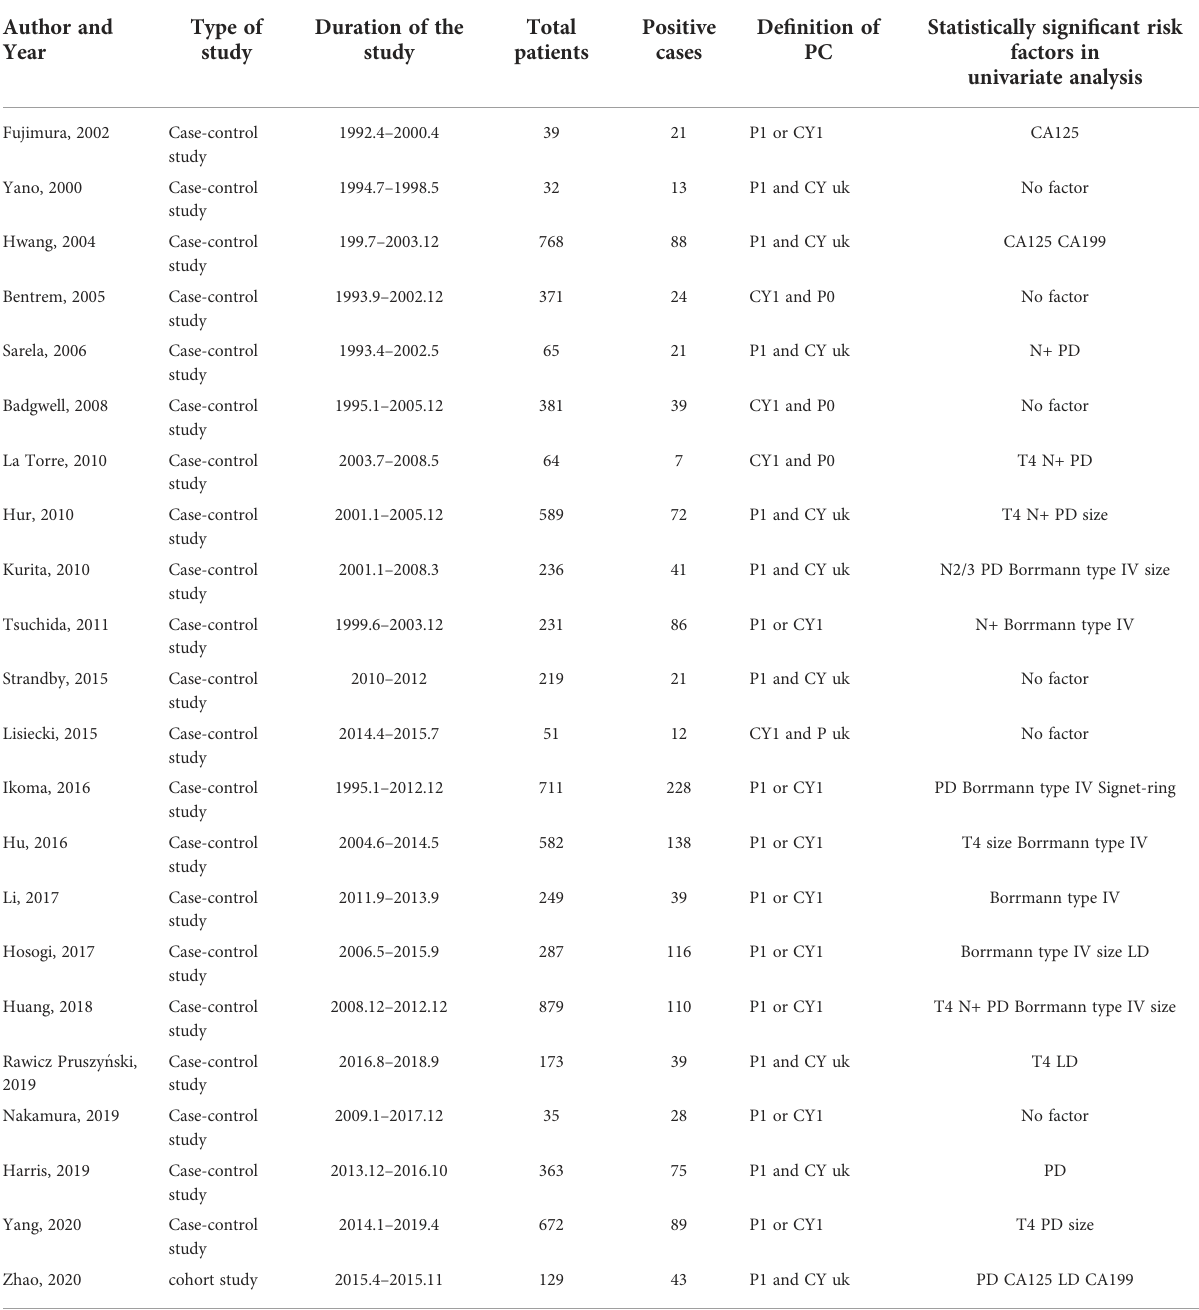
TABLE 1 Baseline characteristics of the included